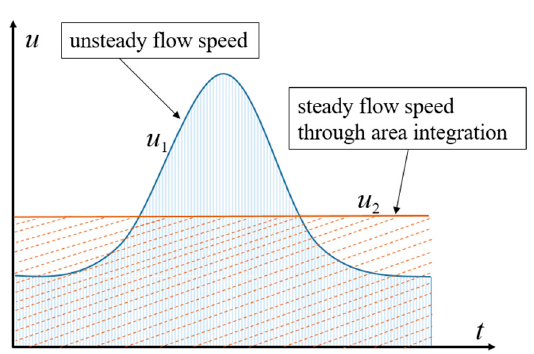
Figure 3. Unsteady flow and steady flow through area integration of the unsteady flow.